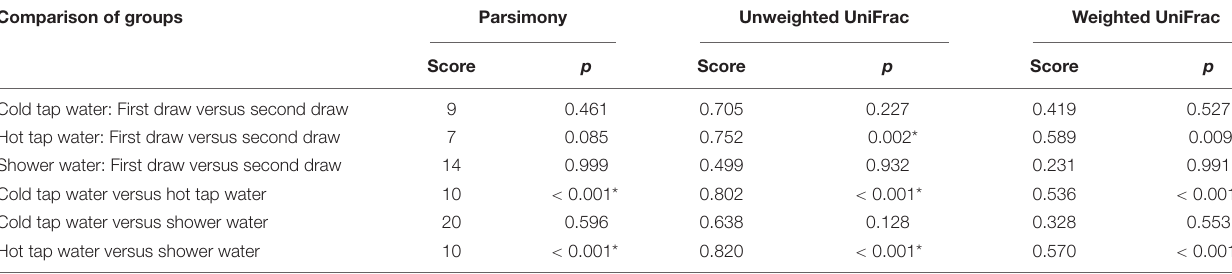
TABLE 3 | Parsimony and UniFrac tests on the clustering of water samples in the phylogenetic dendrogram. Comparison of